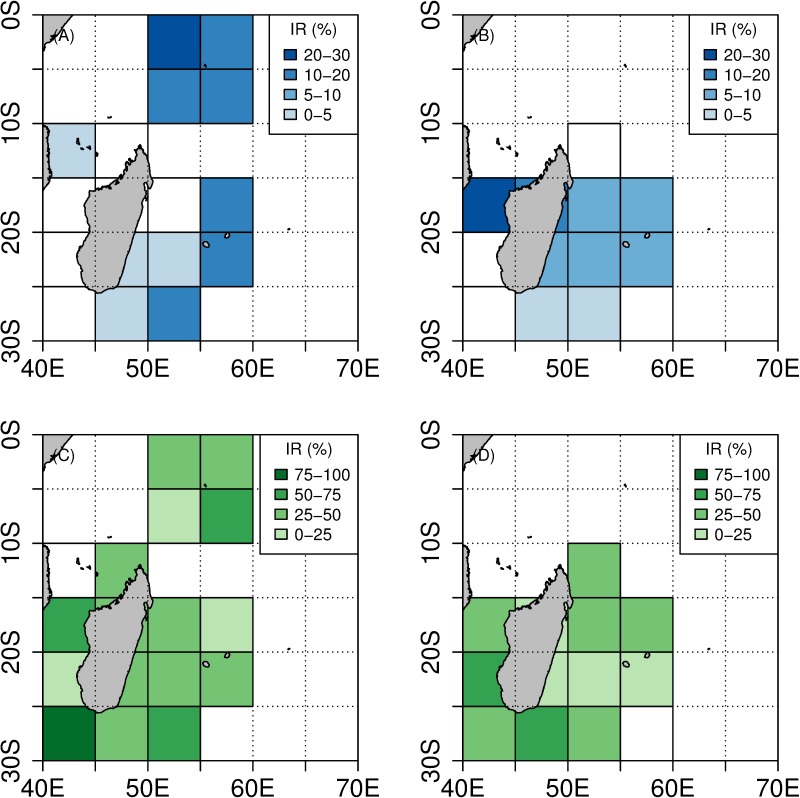
Distribution of IR (in %).IRTW is depicted in blue, IRSH is depicted in green. (A) Distribution of IRTW between 2004 and 2010. (B) Distribution of IRTW between 2011 and 2015. (C) Distribution of IRSH between 2004 and 2010. (D) Distribution of IRSH between 2011 and 2015.